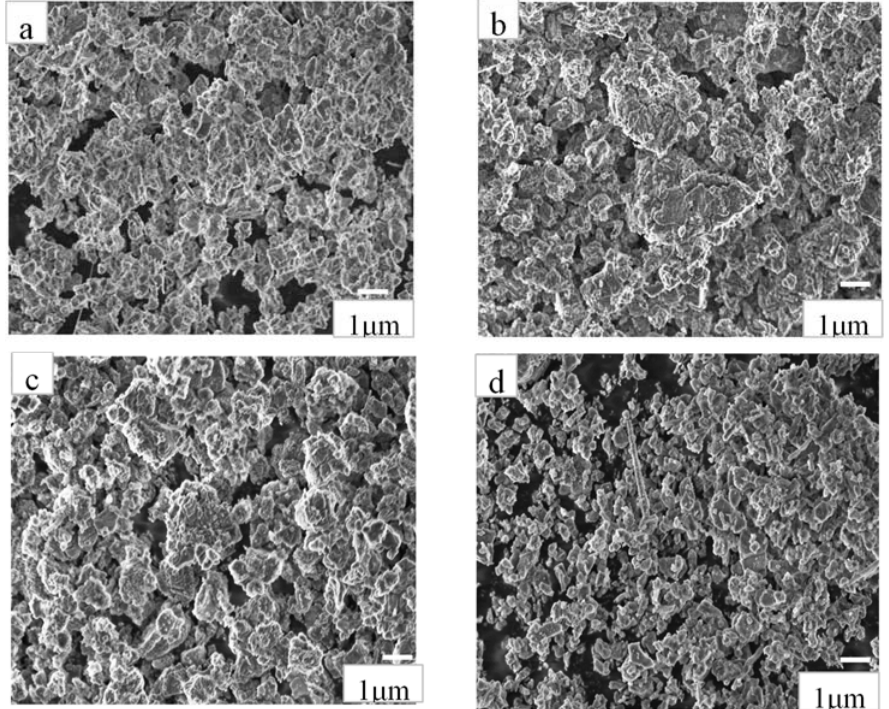
Figure 3. The microstructure of the oxidized powders after respective oxidizing time—( a ) is the reference AlN powder, ( b – d ) are the AlN powder oxidized for 3, 10, and 20 h respectively.